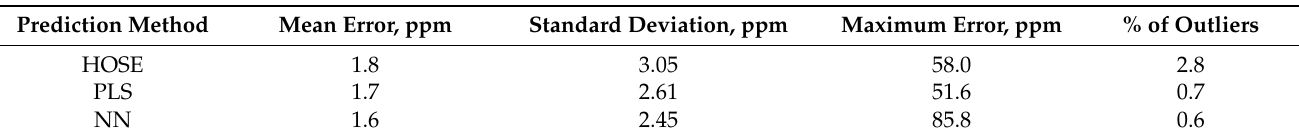
Table 3. The results for the prediction of both 13 C chemical shifts by HOSE codes, PLS and NN algorithms. Outliers are defined as those shifts predicted with an error of more than 10 ppm.